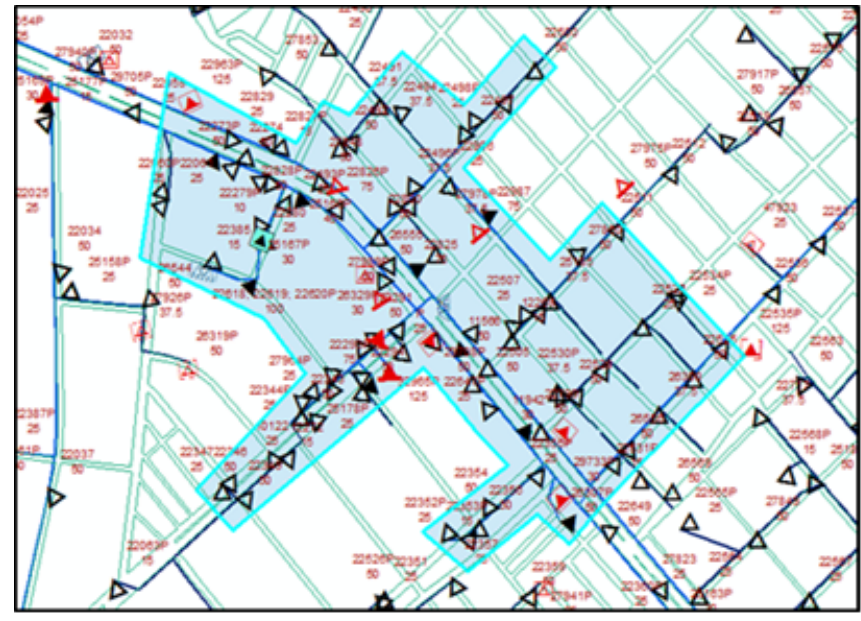
Figure 9. Polygon method of consumers in the group that need to be